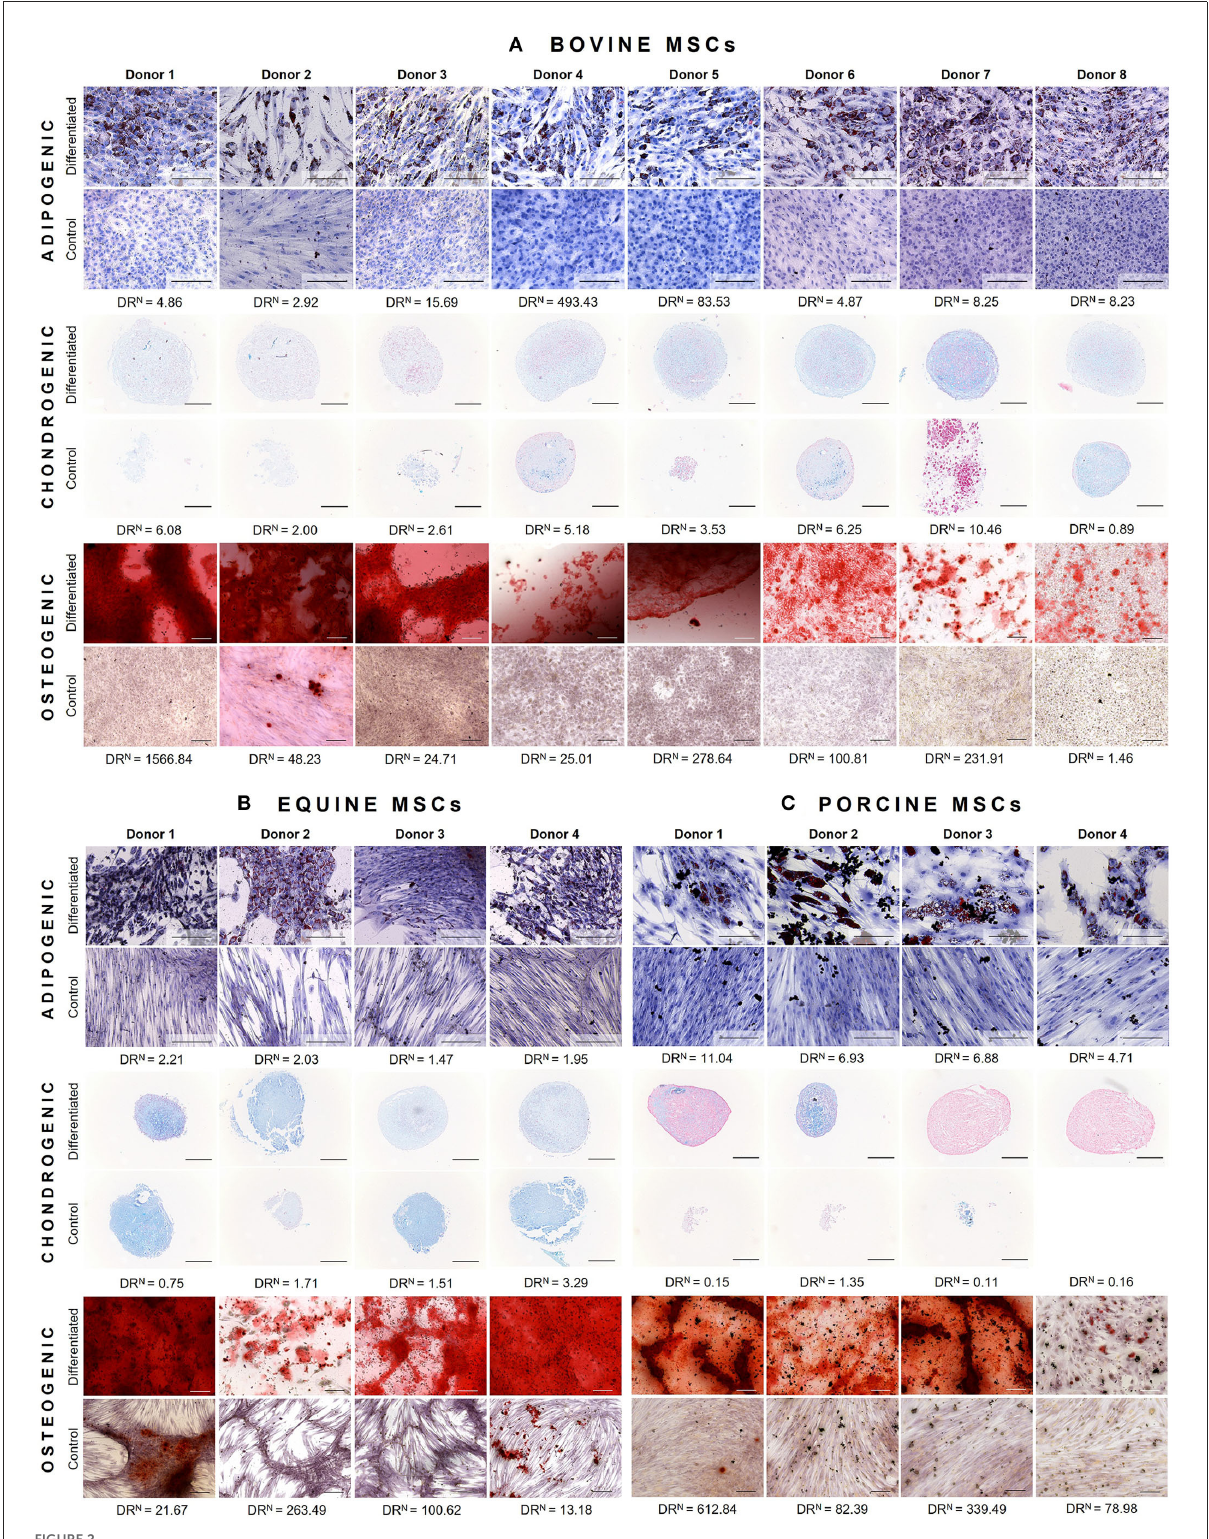
FIGURE2 Representative images of tri-lineage differentiation potential of (A) bovine MSCs ( n = 8), (B) equine MSCs ( n = 4), and (C) porcine MSCs ( n = 4). For each donor, both differentiated MSCs and non-induced controls are shown, as well as the normalized differentiation ratio (DR N ). The latter is calculated by dividing the mean differentiation ratio of differentiated wells by the mean value of the non-induced controls. When this ratio is less than 1, less differentiation is observed when compared to non-induced controls; when the DR N is above 1, a higher differentiation is observed. Scalebar = 200 µ